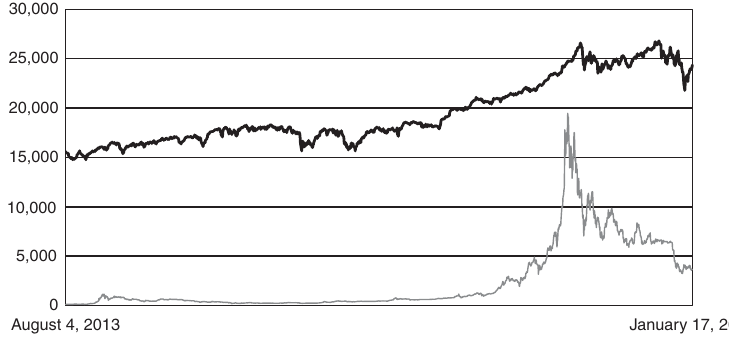
Figure 1. Dow Jones industrial average index and the Bitcoin